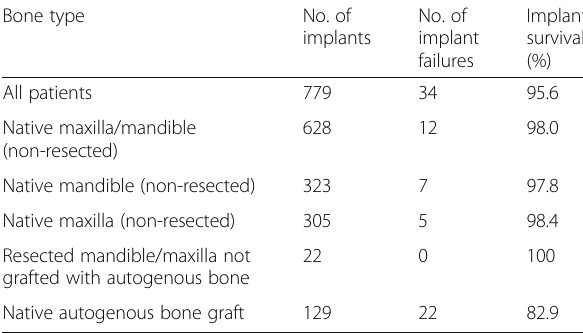
Table 4 Implant survival in specified bone type Bone